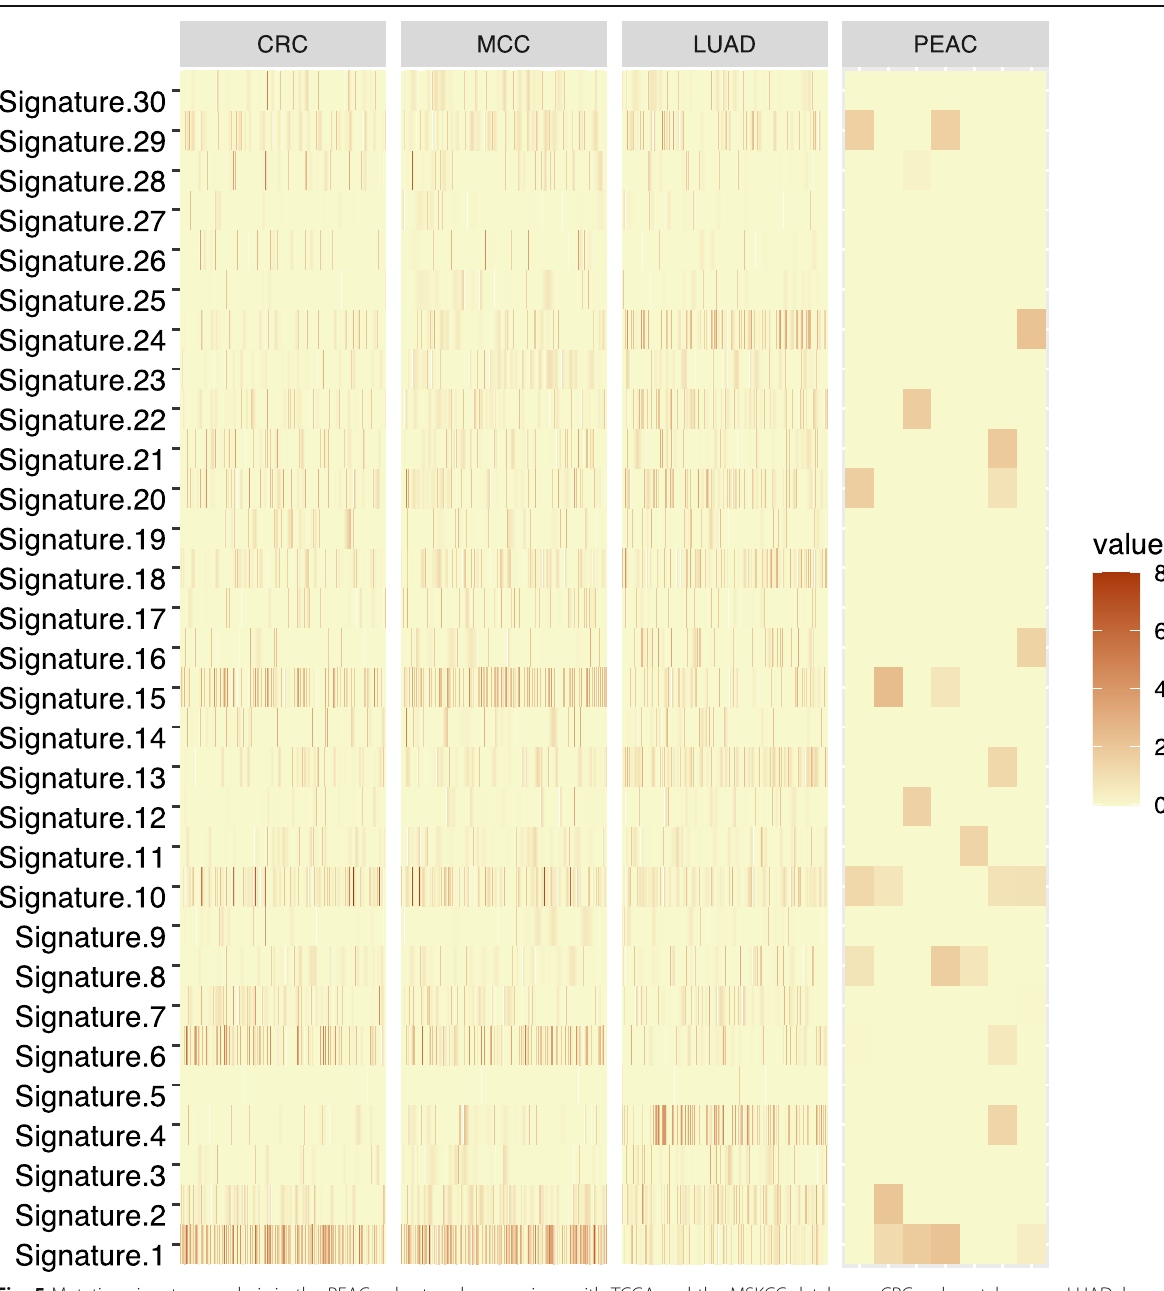
Fig. 5 Mutation signature analysis in the PEAC cohort and comparison with TCGA and the MSKCC databases. CRC, colorectal cancer; LUAD, lung adenocarcinoma; MCC, metastatic colorectal carcinoma; PEAC, pulmonary enteric